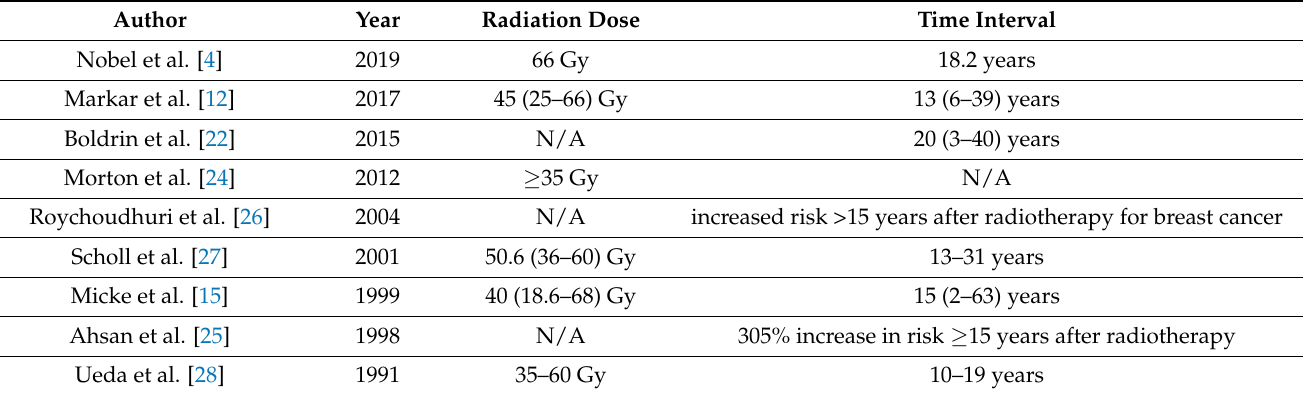
Table 1. Total radiation dose and time interval between irradiation and development of radiation- induced